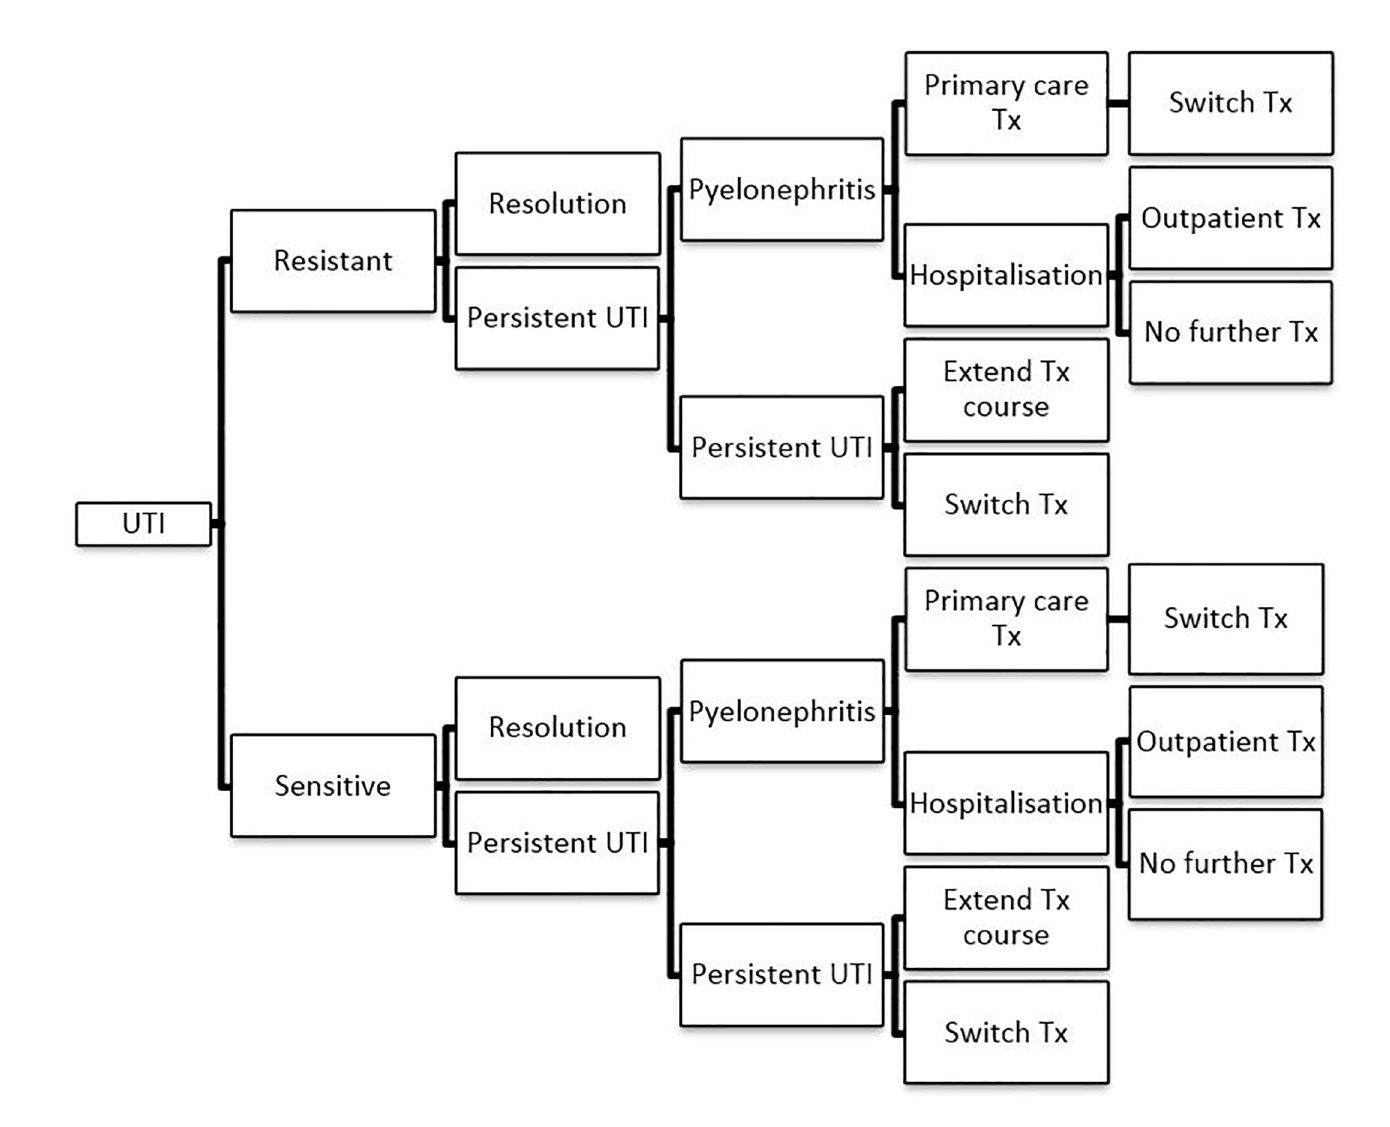
Figure 1. Model pathway. Tx = treatment. UTI = urinary tract